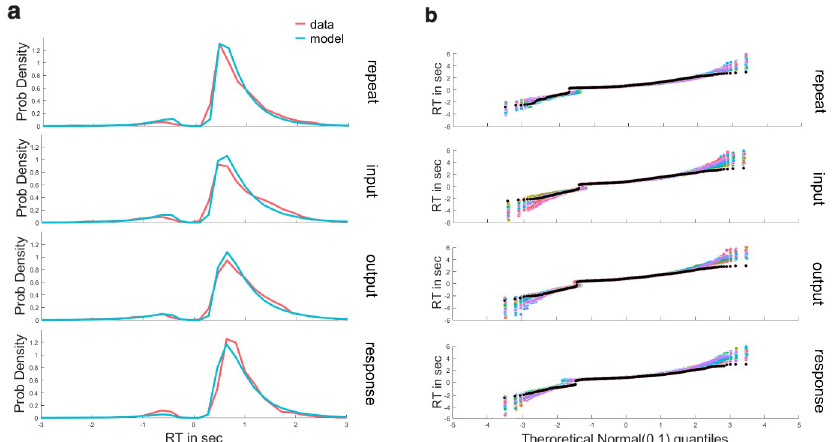
Fig 6. Model fit. (a) Behavioral RT distributions across the group are shown for switching at each level (red line) together with posterior predictive simulation from the HDDM (light blue) in updating trials. Distributions of correct (the right positive tail) and incorrect (left negative tail) trials show good correspondence between data and model. (b) Model fit with Quantile-Quantile plots. Model fit to behavior can be more precisely viewed using quantile-quantile plots, showing quantiles of the empirical behavioral RT distributions (black) against the 50 simulation of RT distribution (colored lines, capturing model uncertainty) from the posterior predictive of the HDDM model, for correct response (positive RT) and incorrect responses (negative RT) in updating trials. Quantiles were computed at the group level. The empirical RT was mostly within the range of the simulated RT with a small over-estimation at the right tail of the